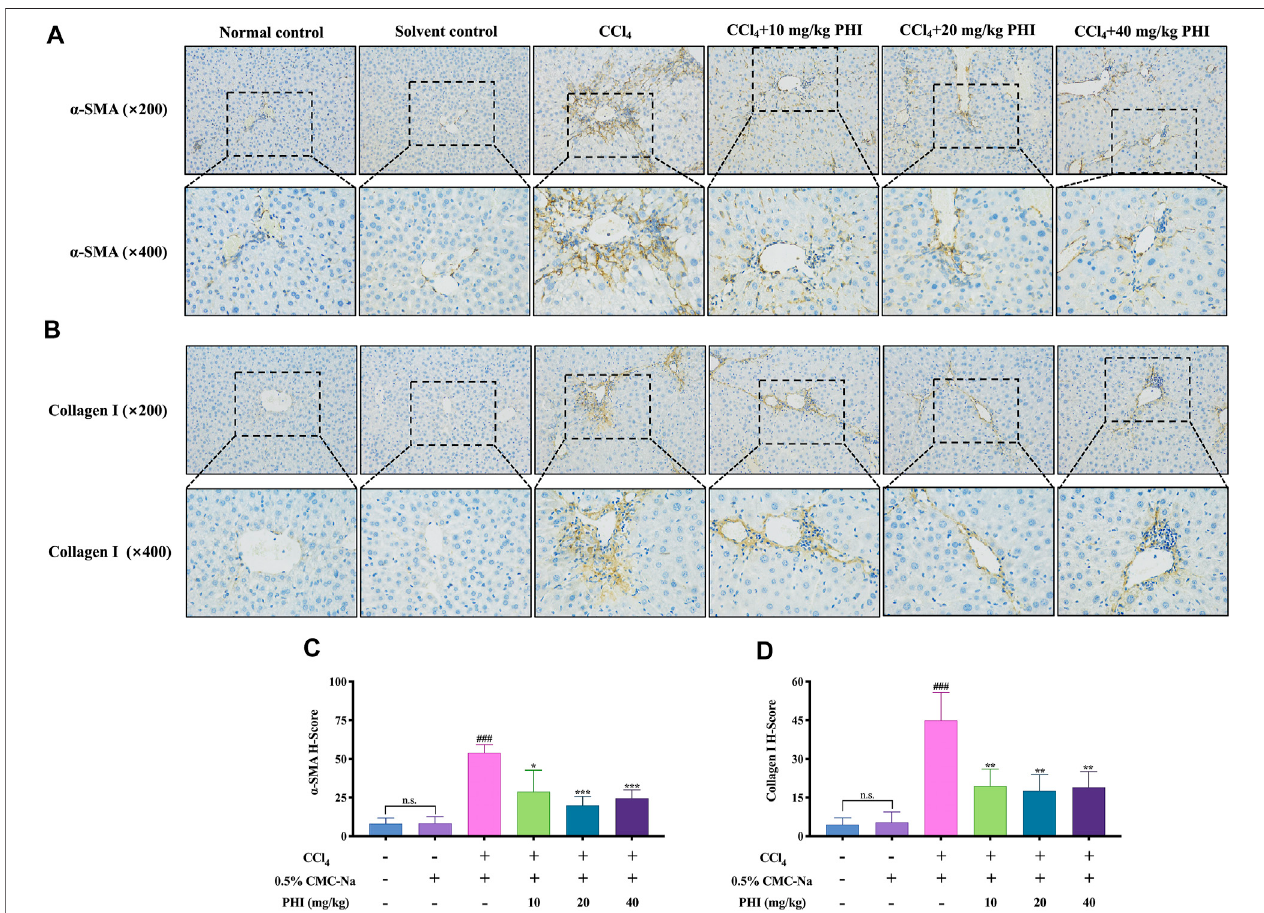
FIGURE 4 | Effect of PHI on the expression of α -SMA and collagen I. (A) Immunohistochemistry staining of α -SMA in the liver tissues ( × 200 and × 400). (B) ImmunohistochemistrystainingofcollagenIinthelivertissues( × 200and × 400). (C) Quantitativeresultsof α -SMAinthelivertissues (D) QuantitativeresultsofcollagenI in the liver tissues. Data was expressed as the mean ± SD ( n (cid:1) 6). ### p < 0.001 represent compared with solvent control group. * p < 0.05, ** p < 0.01, *** p < 0.001 represent compared with CCl 4 group. n. s indicates no signi fi cant.